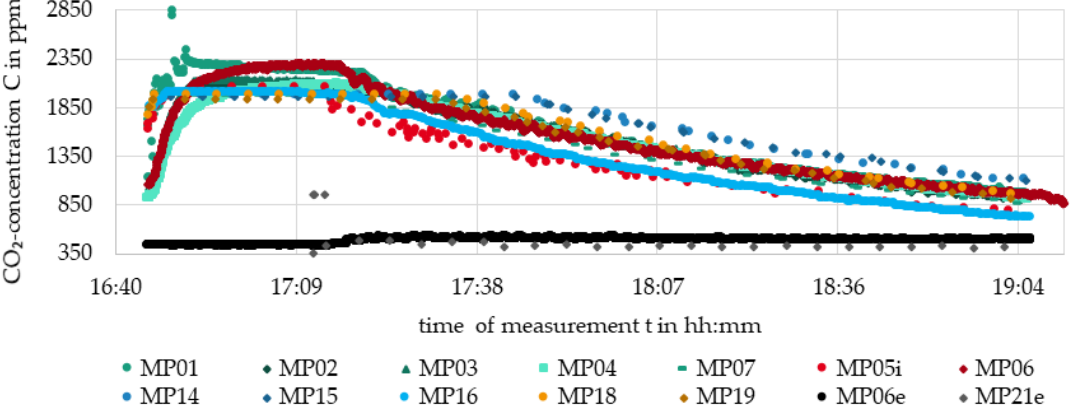
. Figure 5. Example of measured decay curves: V = 28 m 3 · h − 1 , isotherm, horizontal plane at 1.10 m; the Figure 5. Example of measured decay curves: V ̇ = 28 m³ ⋅ h -1 , isotherm, horizontal plane at 1.10 m; marker colours correspond to Figure the marker colours correspond to Figure 4A.